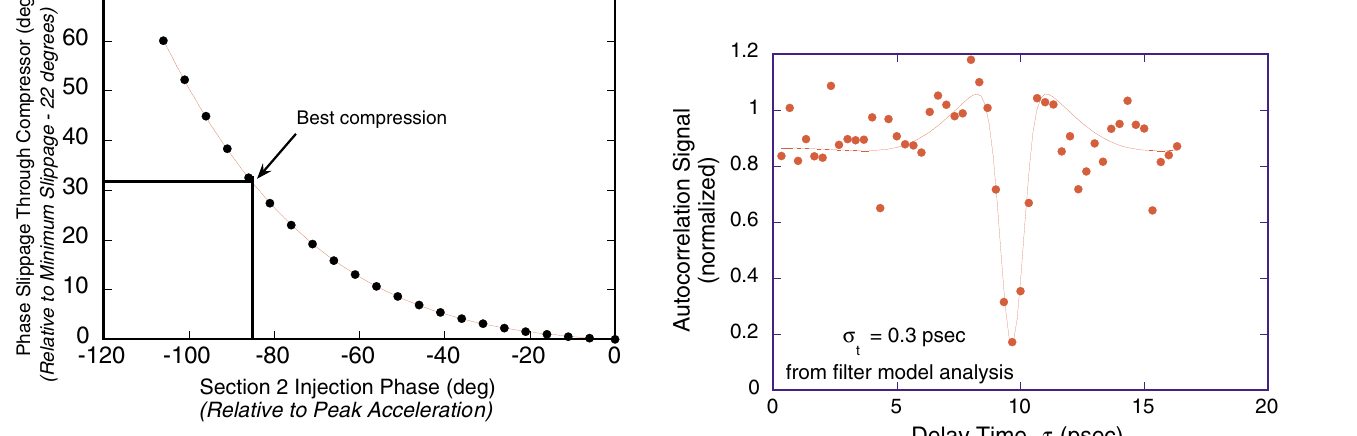
FIG. 23. (Color) Model calculation of the phase slippage in the compressor as a function of injection phase. The injected phase is relative to the phase for best acceleration, 20 (cid:1) ahead of